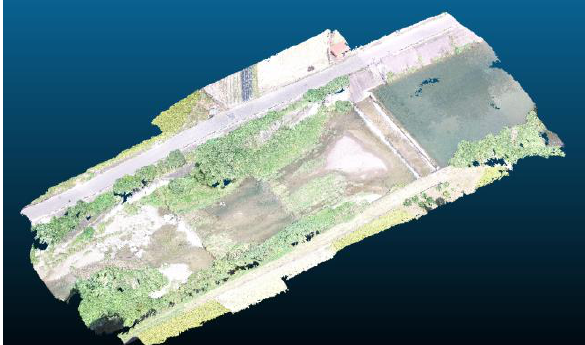
Figure 5. Three-dimensional point cloud data made of Kashiigawa River